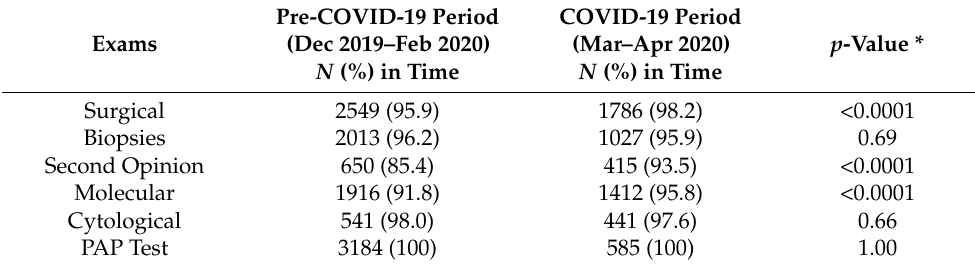
Table 3. Turn Around Time of exams performed in Pathology